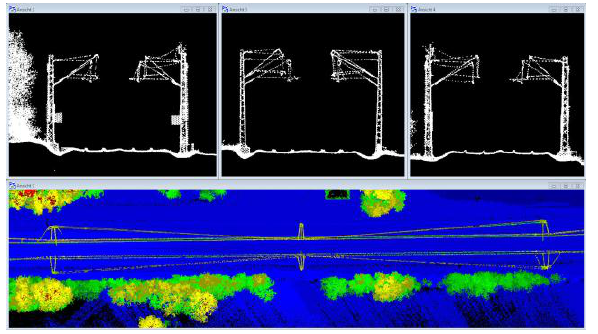
Figure 16: Measurement of the catenary wire